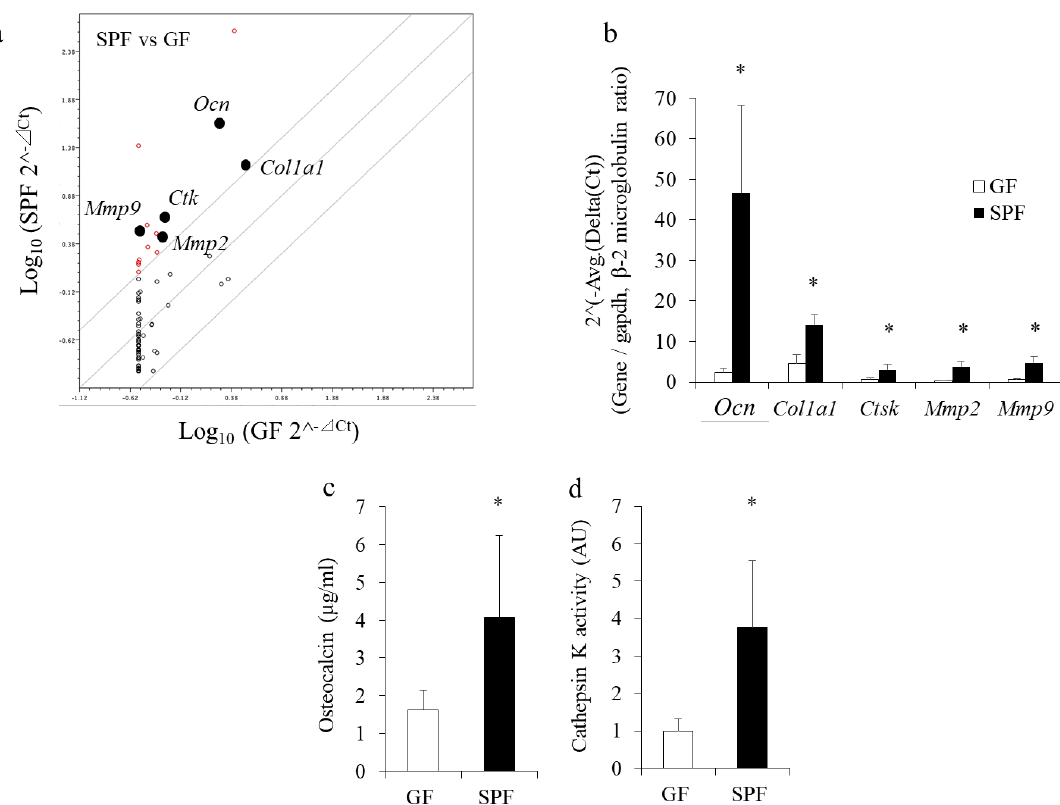
Figure 3. Enhanced expression of bone metabolism marker genes and proteins in SPF alveolar bone. Alveolar bone from 8-week-old GF and SPF mice was harvested for gene expression assays and ELISA. Total RNA isolated from alveolar bone was analyzed by polymerase chain reaction (PCR) array ( a ) and real-time PCR ( b ). ( a ) PCR array profiling of osteogenic gene expression in GF and SPF alveolar bone. Data from SPF (ordinate) and GF (abscissa) evaluations are plotted. Constantly elevated or varying levels of gene expression are indicated by red open circles. Circles on the diagonal line represent relative changes in metabolite levels that were stable between the two groups. ( b ) Closed circles in Figure 3a denote expression of genes that were significantly higher in SPF mice than GF mice (>4 times) examined in Figure 3b. ( c , d ) Alveolar bones from mandibles were manually homogenized, and proteins